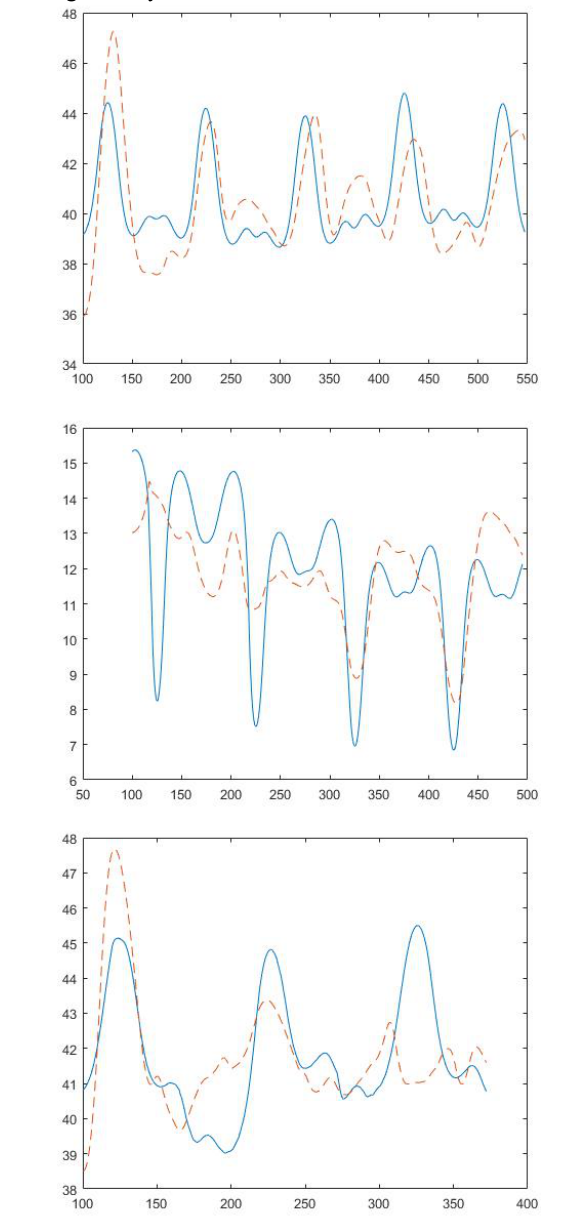
Fig. 22. Approximation of one of the trajectories using the first 4 principal components in geometry A. Gradually for 20, 50 and 100